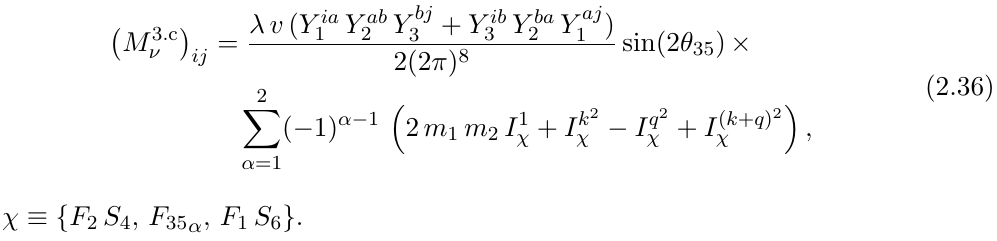
The neutrino mass matrix